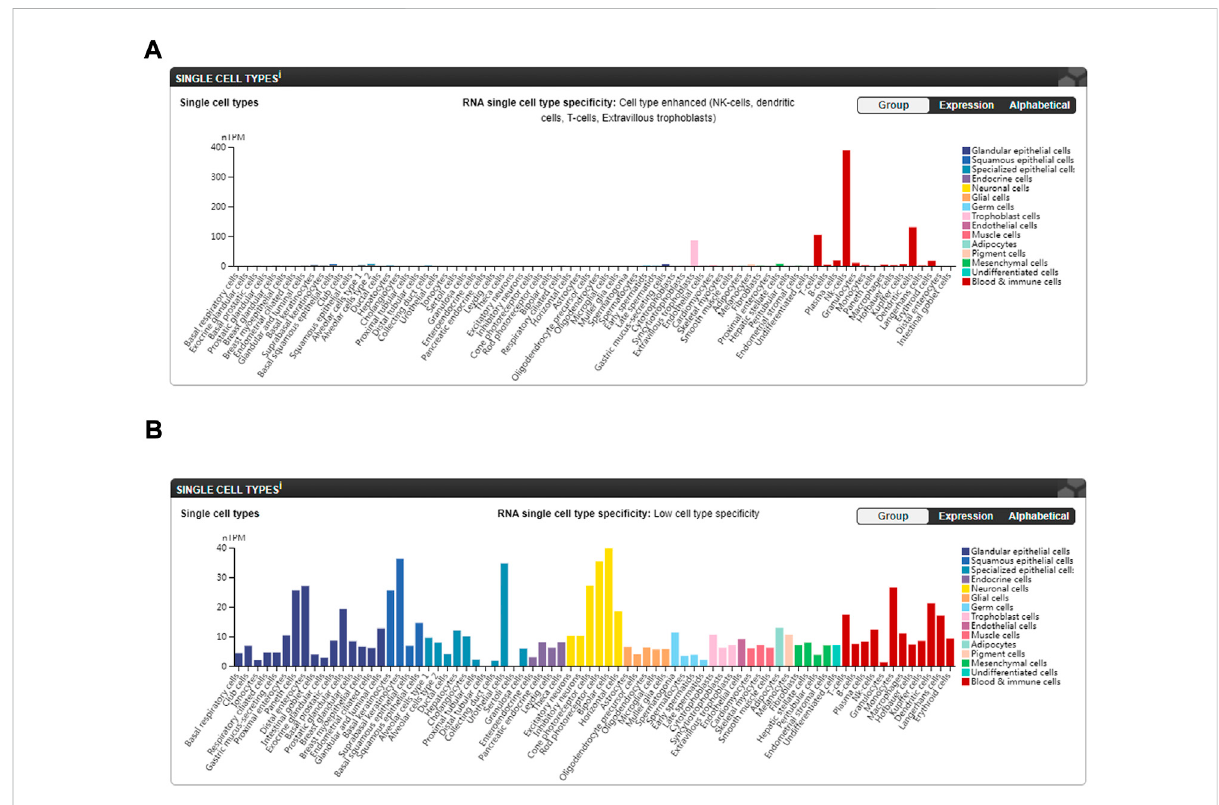
FIGURE 7 Expression of hub genes in different single-cell types of normal subjects from the HPA website (Karlsson et al., 2021). (A) Expression of IL2RB in different single-cell types (available from v21.1. proteinatlas.org: https://www.proteinatlas.org/ENSG00000100385-IL2RB/single+cell+type). (B) Expression of ZDHHC18 in different single-cell types (available from v21.1. proteinatlas.org: https://www.proteinatlas.org/ENSG00000204160-